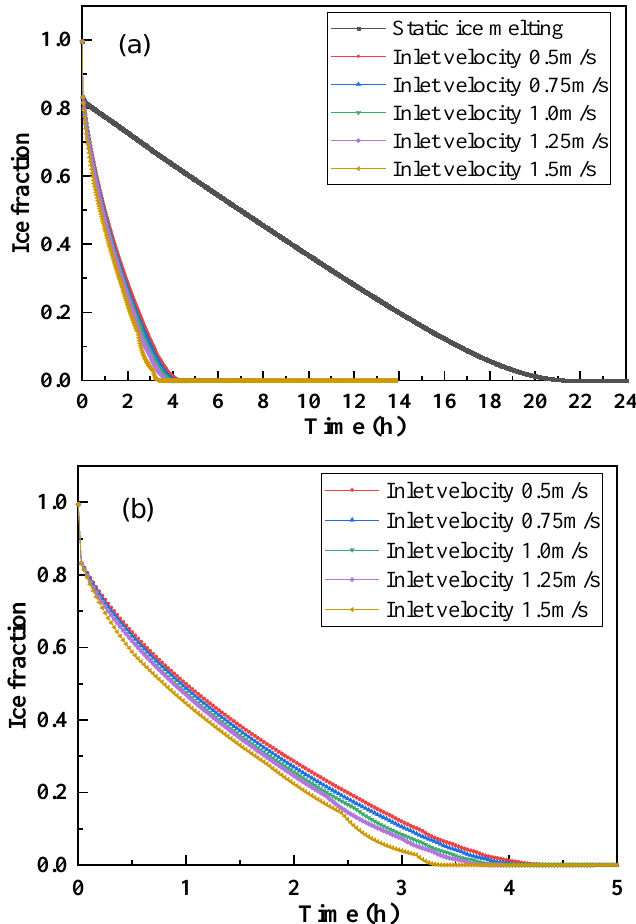
Figure 12. Curves for the variations of ice storage fraction with the time in the ice melting process under different fed water velocity from the main pipe inlet ( a ) with static ice melting and ( b ) without ice melting.